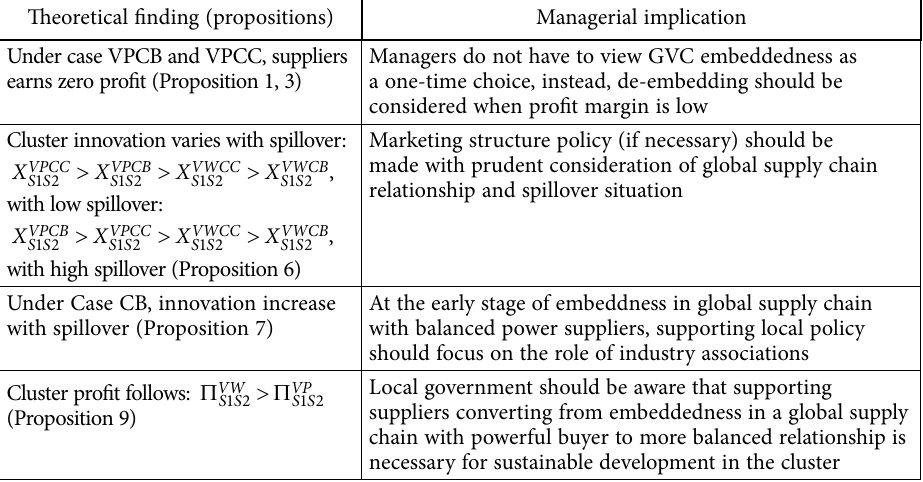
Table 5. Linking propositions with managerial implications (source: author’s summary) Theoretical finding (propositions) Managerial